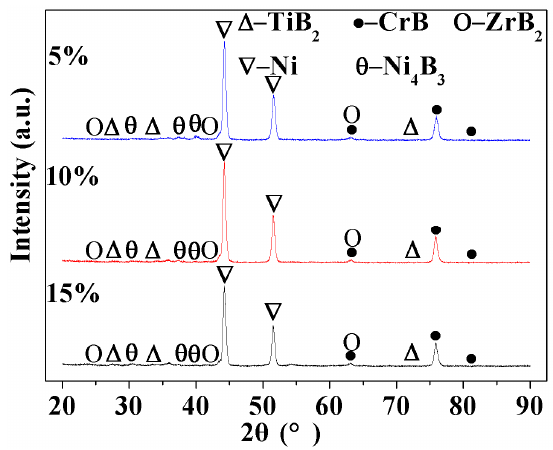
Figure 2. X-ray diffraction (XRD) spectra of three kinds of NiCr–TiB 2 –ZrB 2 coatings.